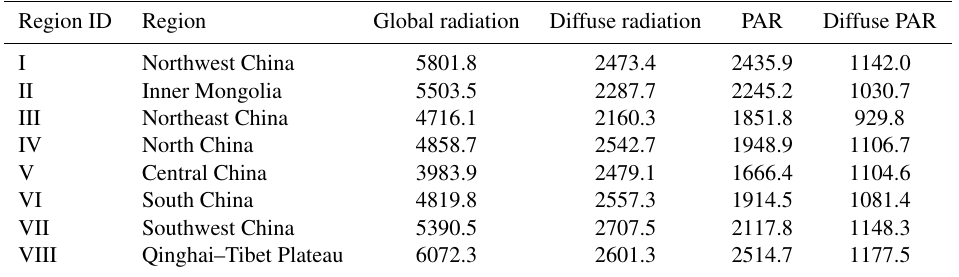
Table 2. Global radiation, diffuse radiation, PAR, and diffuse PAR averaged from 1981 to 2010 for each region in China. Units are MJm − 2 yr − 1 .